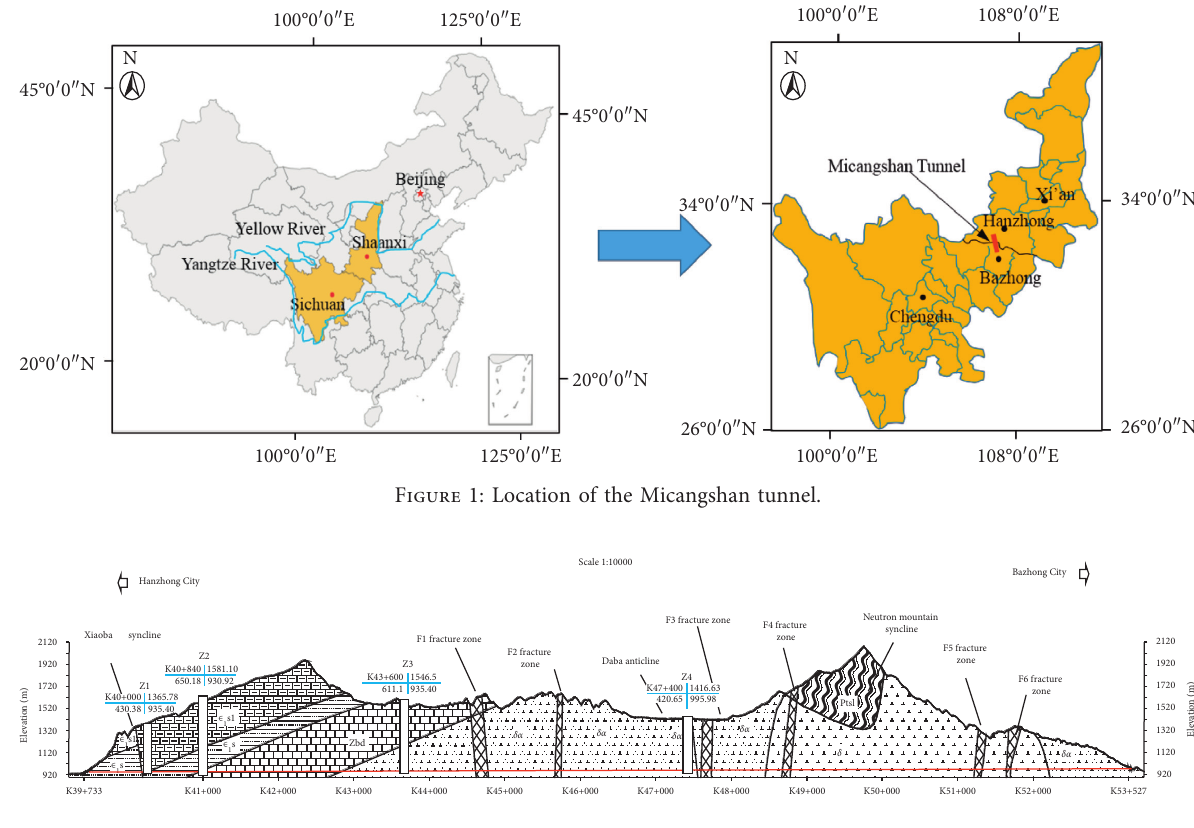
Figure 2: Overview of the geological structure of the Micangshan